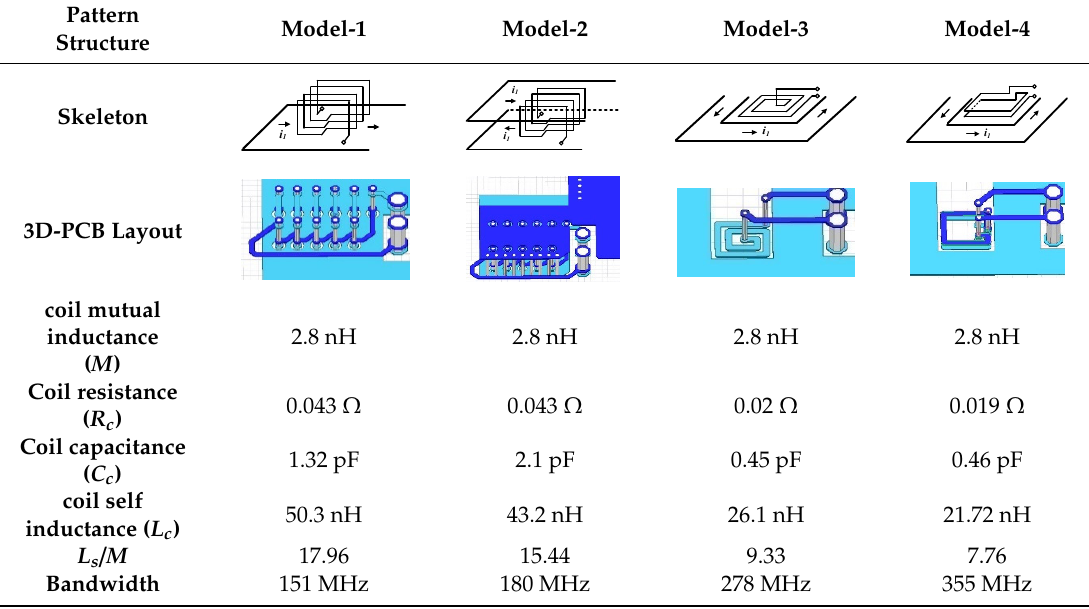
Table 1. Comparison of the dependent coil structure.